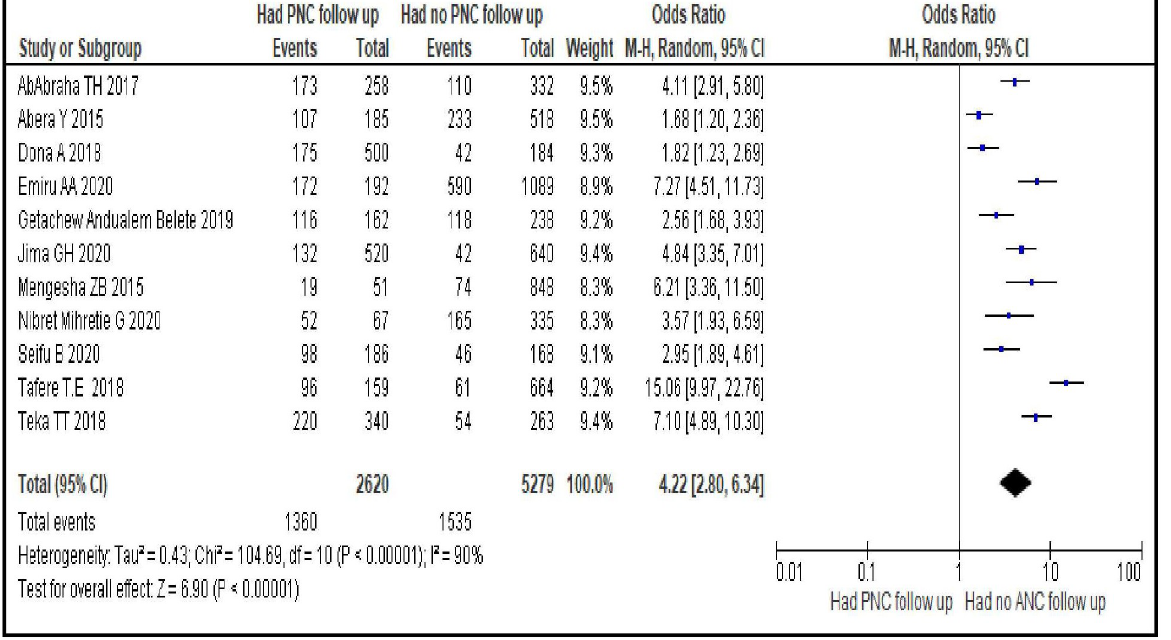
Fig 11. Association between women’s PNC follow-up during last pregnancy and modern contraceptive uptake during postpartum period, 2021.